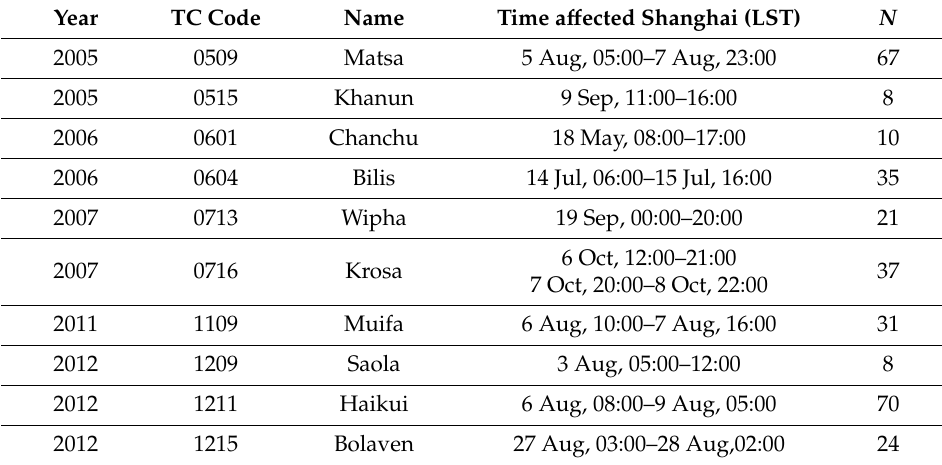
Table 1. Typhoons that have affected Shanghai for longer than 3 h between 2005 and 2013. N is the number of hours Shanghai was impacted. A total of 311 h of data were analyzed. TC: Tropical cyclone